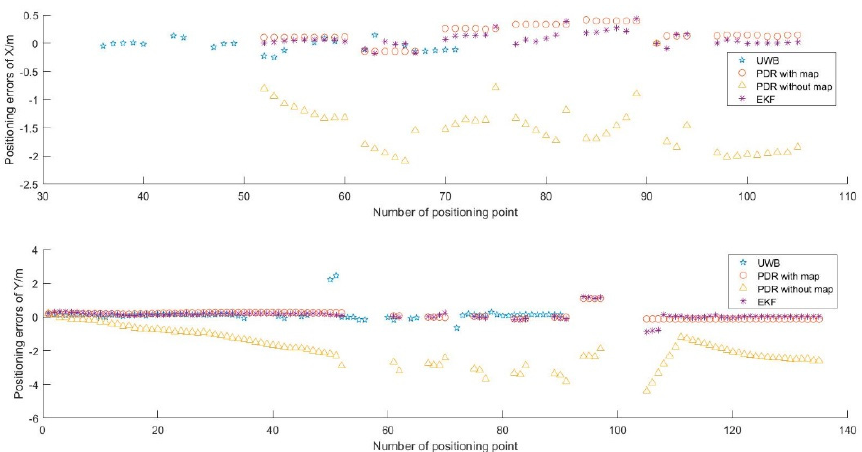
Figure 14. Positioning error of four methods, ( a ) Positioning error in X direction, ( b ) Positioning error in Y direction.